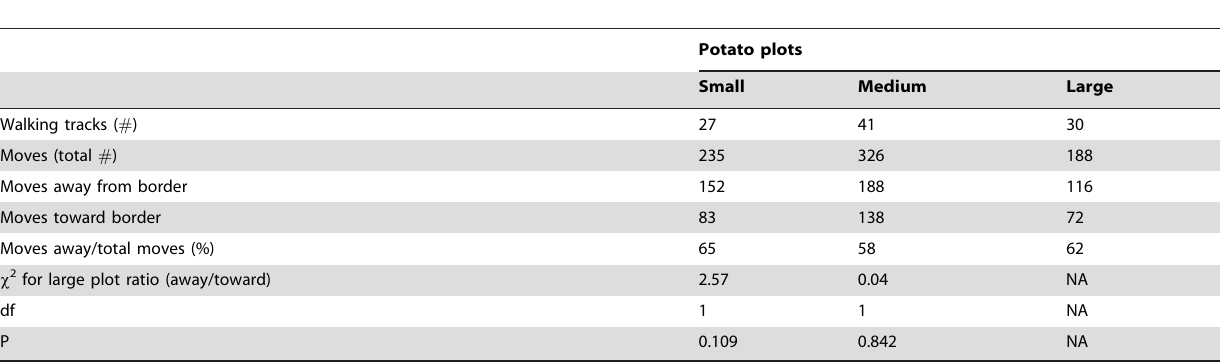
Table 4. Influence of patch size on the movement pattern of walking adult Colorado potato beetles in relation to the crop borders.